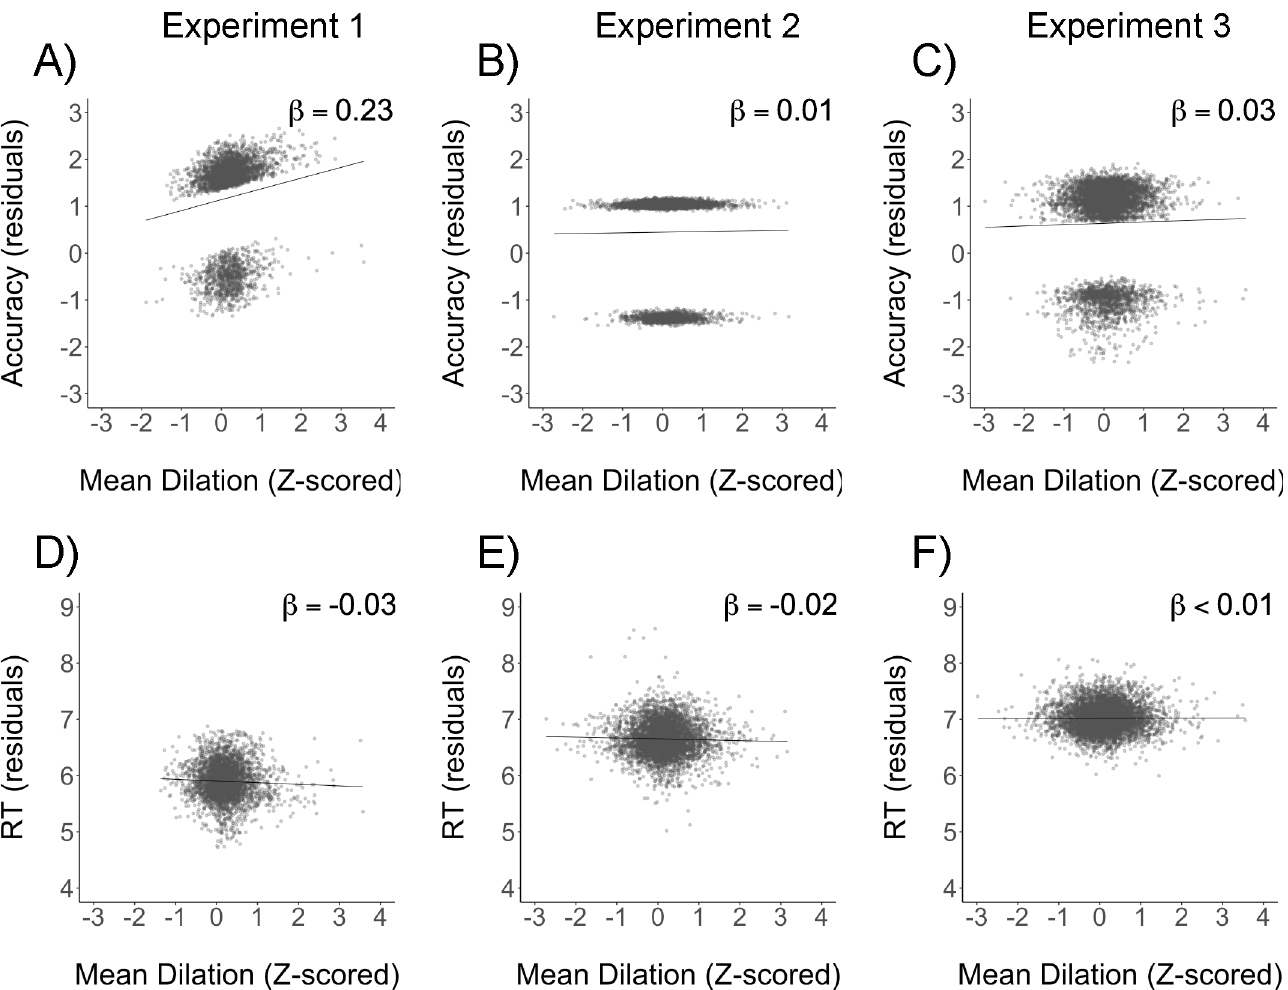
Fig 3. Partial regression plots of linear mixed effectsresults from Experiments 1–3. (A)–(C) show accuracy residualsafter controllingfor all other fixed and randomeffects plotted againstmean dilation for Experiment 1 (A), Experiment 2 (B) and Experiment 3 (C). Accuracy was coded as 0 for incorrect and 1 for correct, and consequently correct and incorrect trial residualsform separate clusters of dots in the scatterplots. (D)–(F) show RT residualsafter controlling for all other fixed and randomeffects plotted againstmean dilationfor Experiment 1 (D), Experiment 2 (E) and Experiment 3